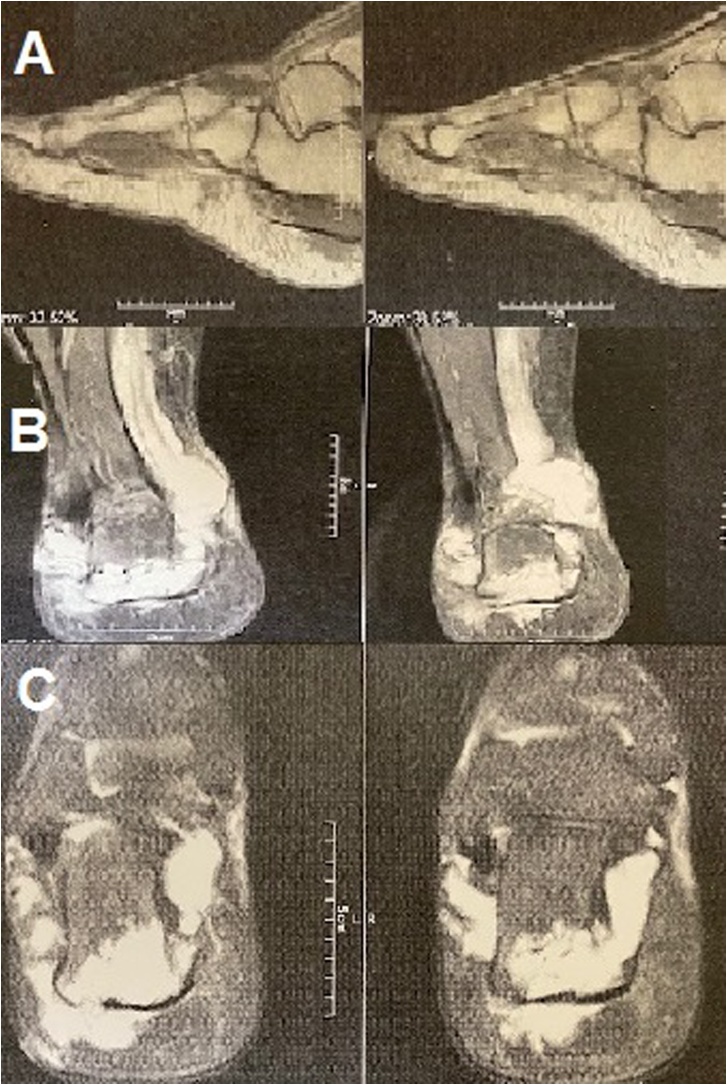
T1- and T2-weighted MRI in sagittal (A, B) and axial (c) planes demonstrating a large soft tissue mass superficial to the deep plantar fascial plane and embedded within the subcutaneous and deep dermis tissue. The lesion has a low signal intensity on T1weighted images (A) and heterogeneous signal intensity on T2-weighted images (B, C).